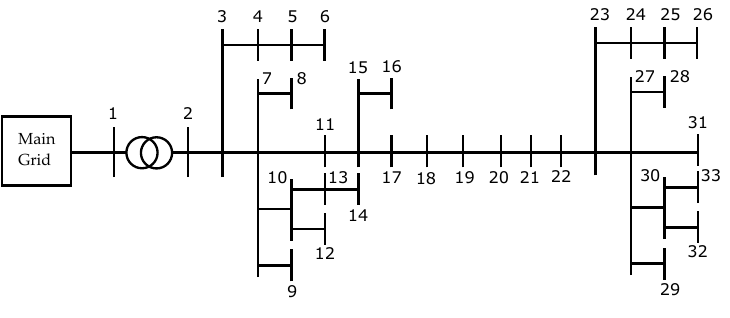
Figure 3. LV distribution